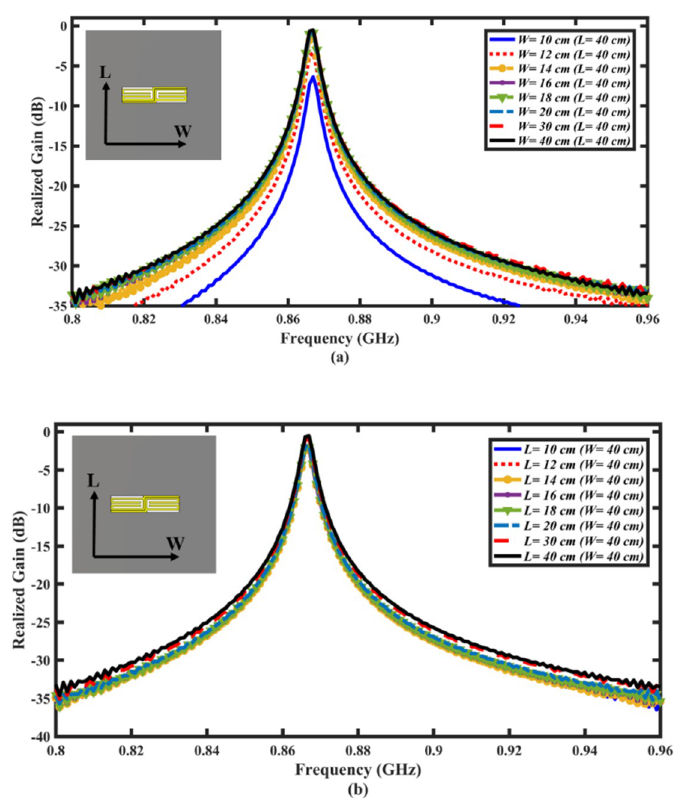
Figure 9. The simulated realized gain ( a ) varying the length of backing metal for fixed width; ( b ) varying the width of the backing metal for fixed length.